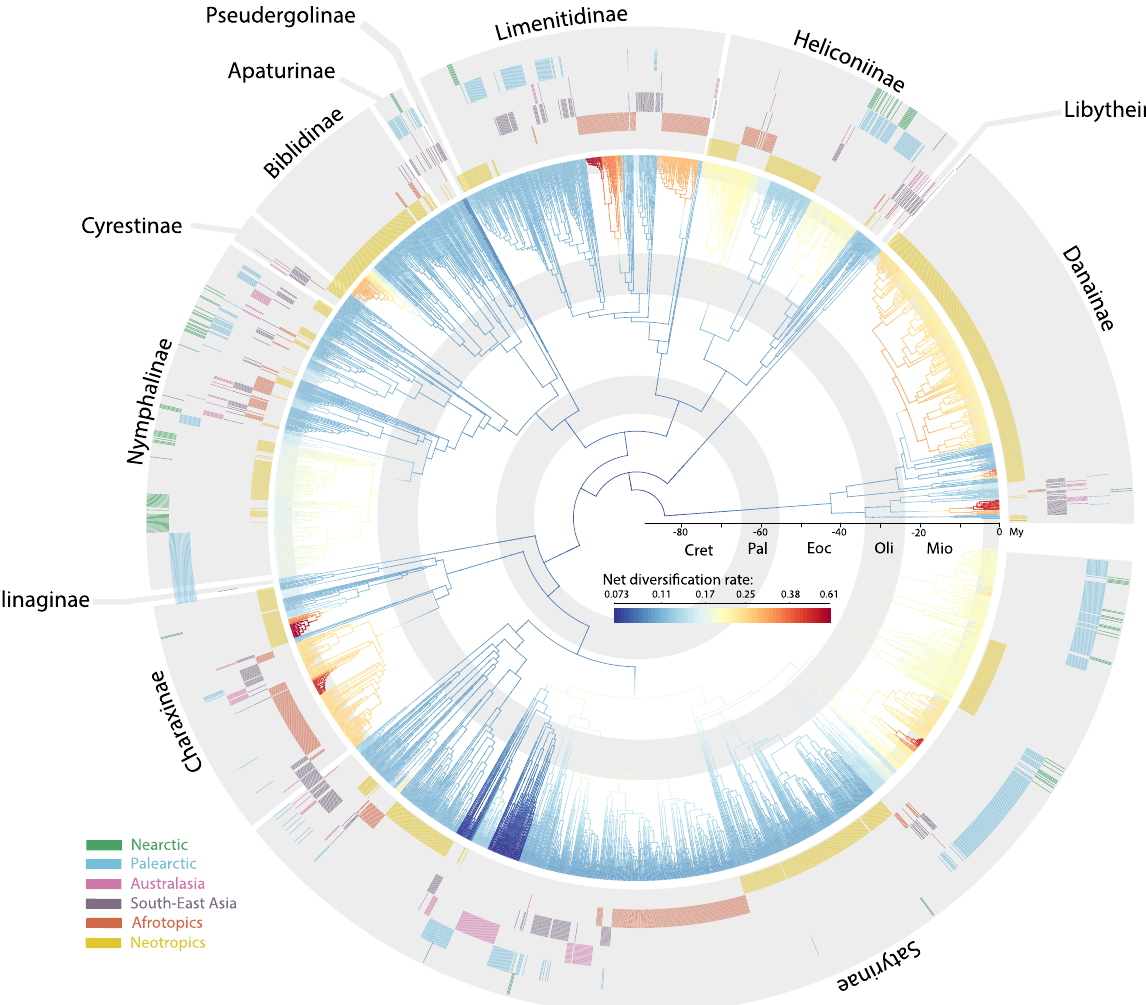
Fig. 1 Time-calibrated phylogenetic tree of brush-footed butter fl ies (Nymphalidae) with biogeographic distribution of extant species and branch net diversi fi cation rate estimated by BAMM. Colored bars in outer circles indicate the biogeographic distribution of each terminal taxon included in the tree. Branches are colored according to the average posterior net diversi fi cation rate from a birth-death analysis as performed with BAMM. Subfamilies are indicated outside the tree. Gray circles inside the phylogeny indicate geological time periods: Cret = Cretaceous, Pal = Paleocene, Eoc = Eocene, Olig = Oligocene, Mio =